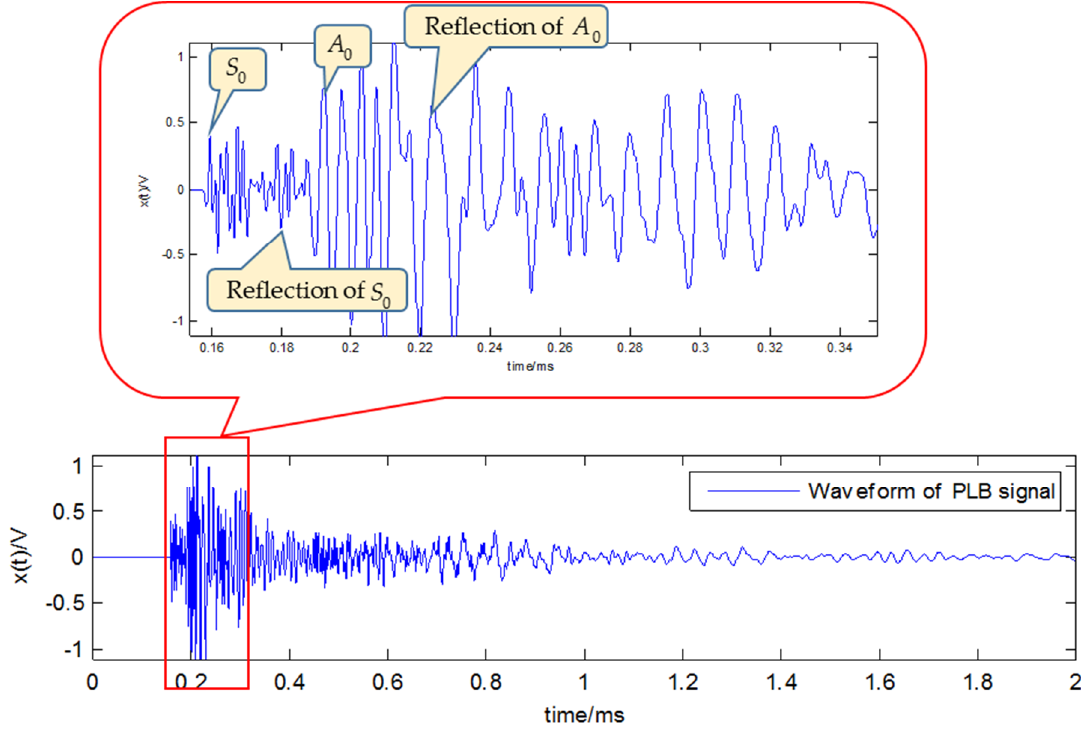
Figure 11. The waveform of the PLB signal.